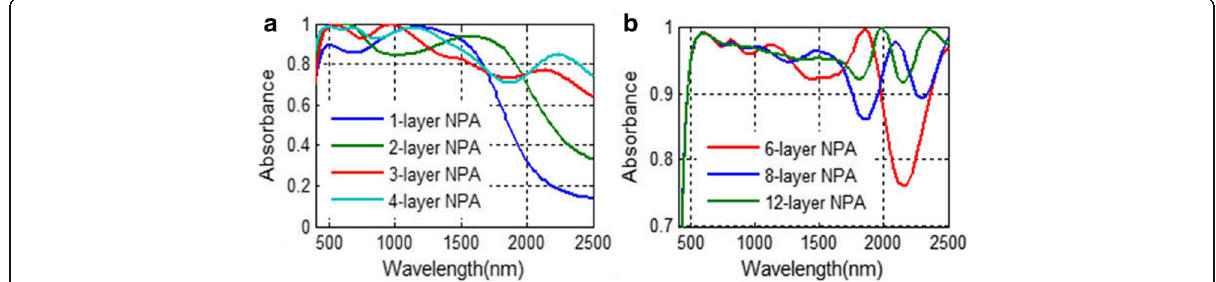
Fig. 3 a , b Absorbance of the NPA structure with multiple layers applied. N -layer NPA means that NPA with N MD